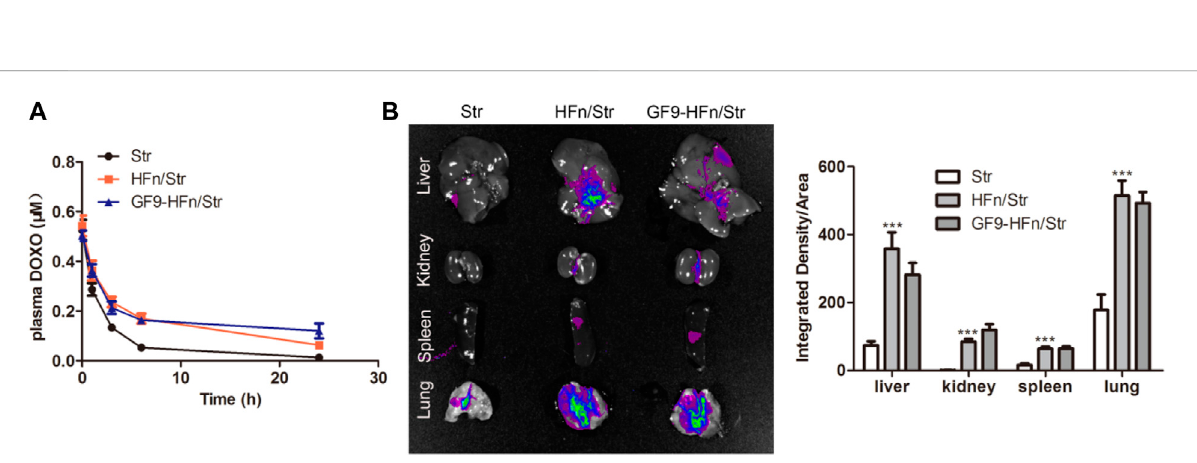
FIGURE 5 Pharmacokineticsanalysisonnanomedicines. (A) TheserumpharmacokineticsanalysisonStr,HFn/Str,andGF9-HFn/Str. (B) Thedistributionof streptomycin in tissues. *** p < 0.001 vs .